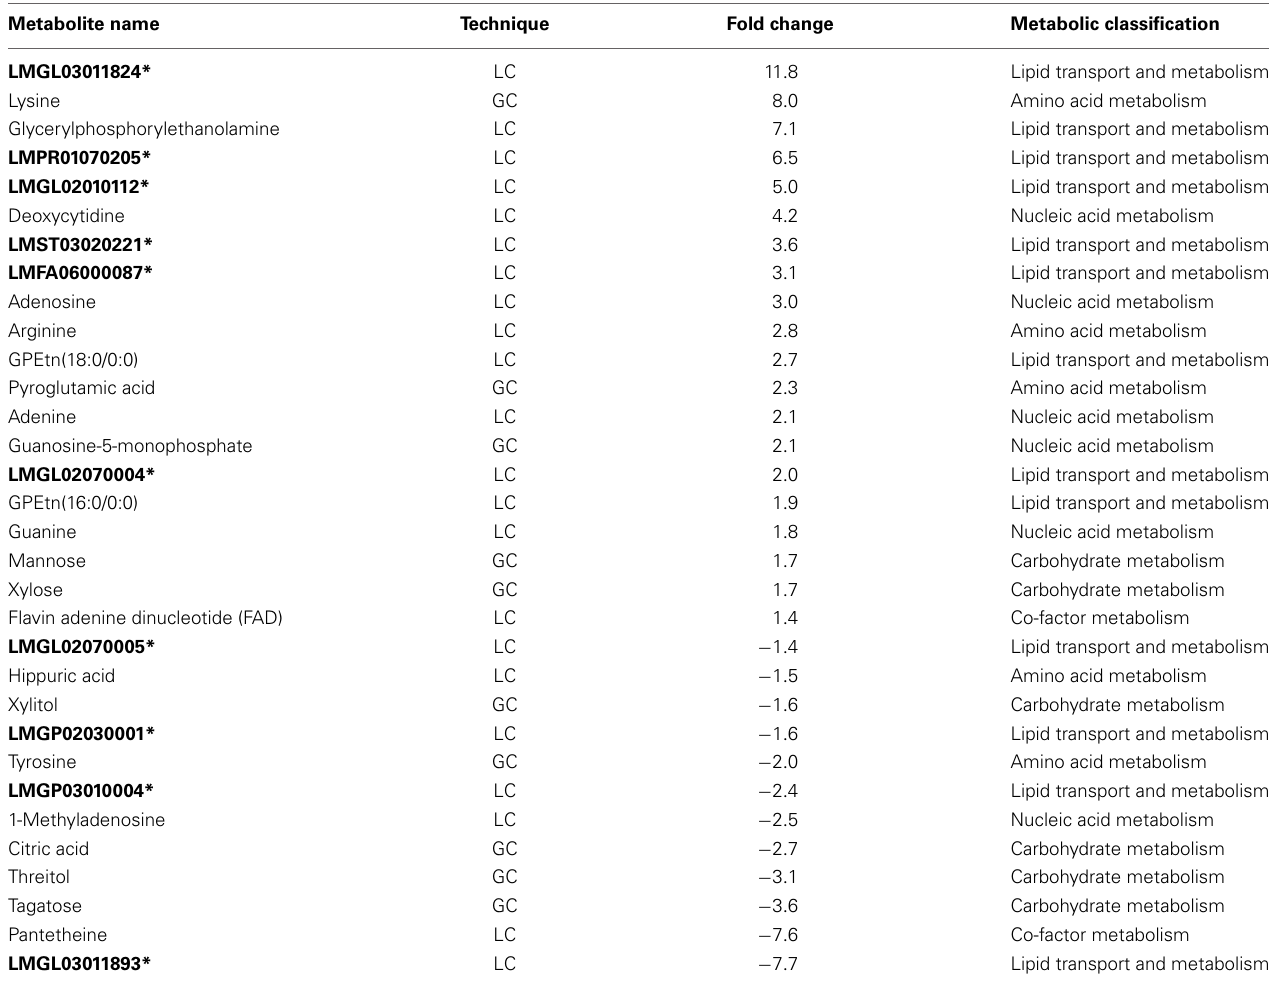
Table 1 | Relative abundance of significantly differential metabolites (MAP (cid:2) mpt D vs.